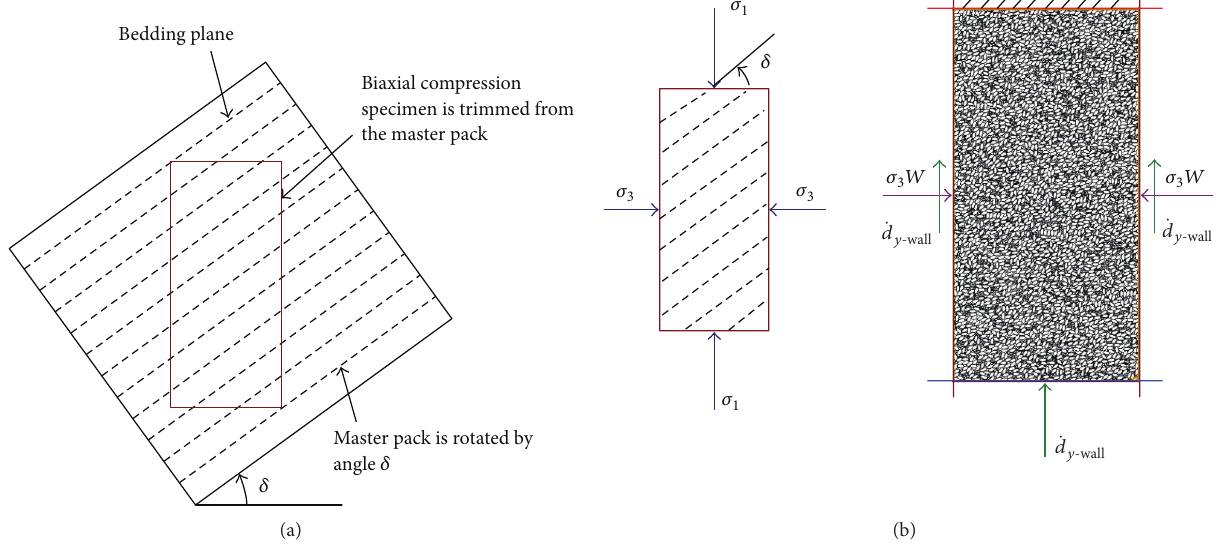
Figure 3: Specimen preparation and boundary of biaxial compression simulations: (a) fabrication of specimen with a tilting angle of 𝛿 (Fu and Dafalias [18]) and (b) the boundary control of the